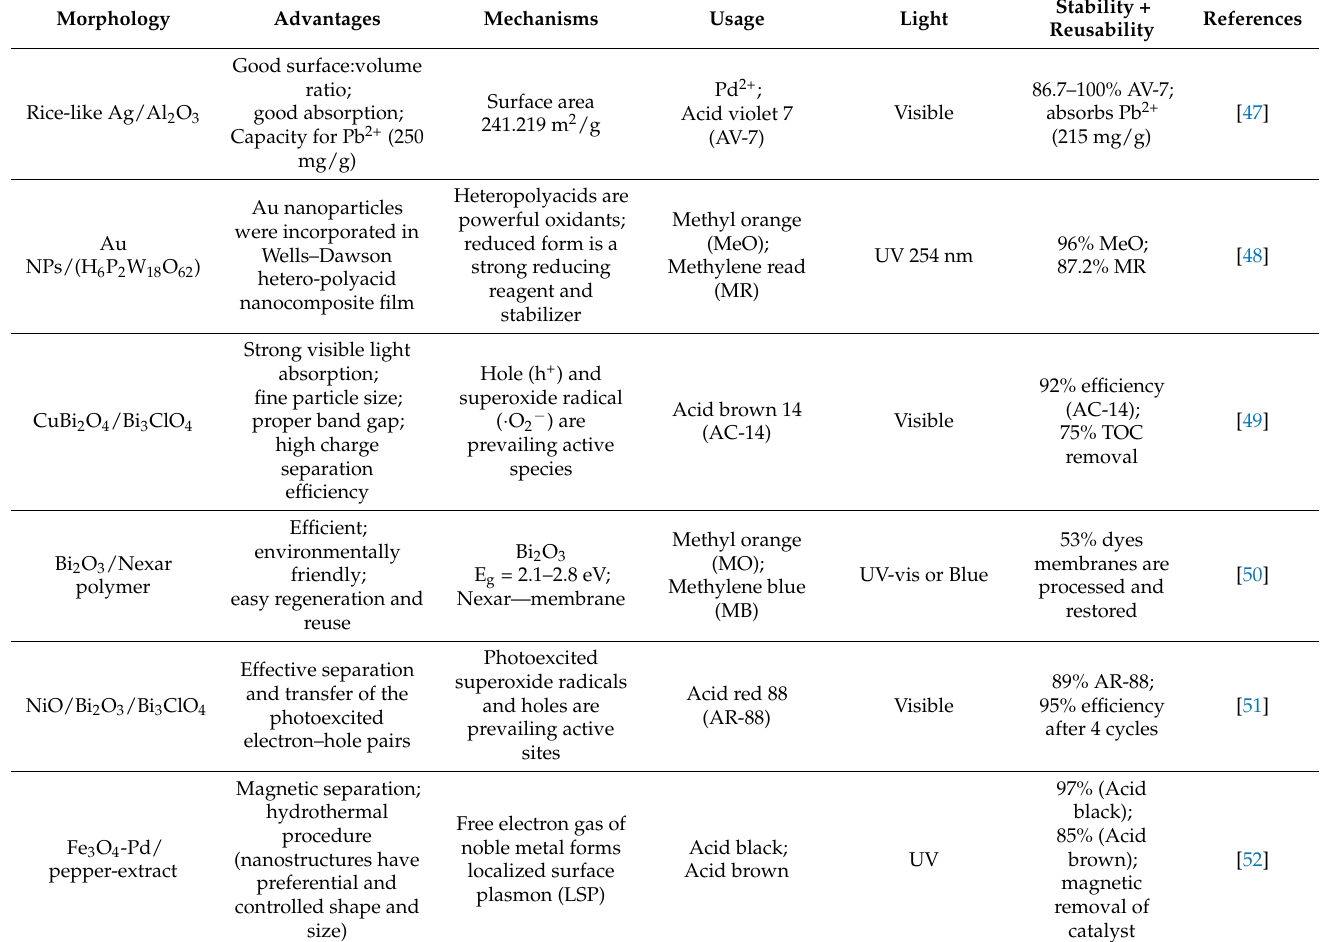
Table 3. Other nanocomposites for photo-degradation of azo